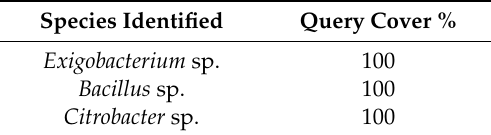
Table 1. Culture characterization of anaerobic pure cultures that survived exposure to Pd(II) during culture isolation.